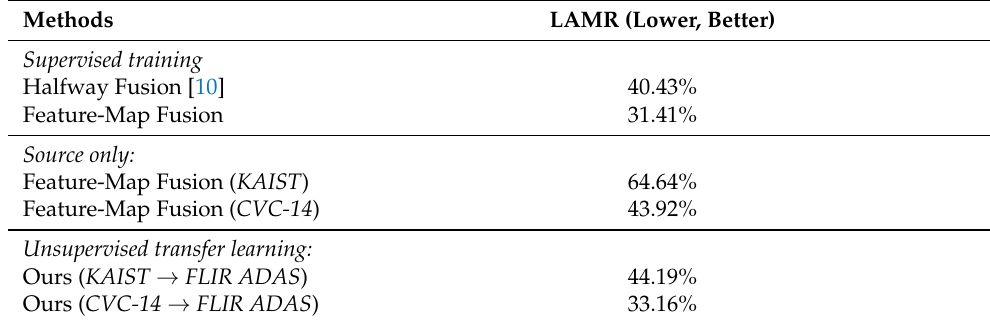
Table 2. Detection performance comparisons on FLIR ADAS dataset. The supervised training is performed on FLIR ADAS dataset directly using manual labels of the “person”